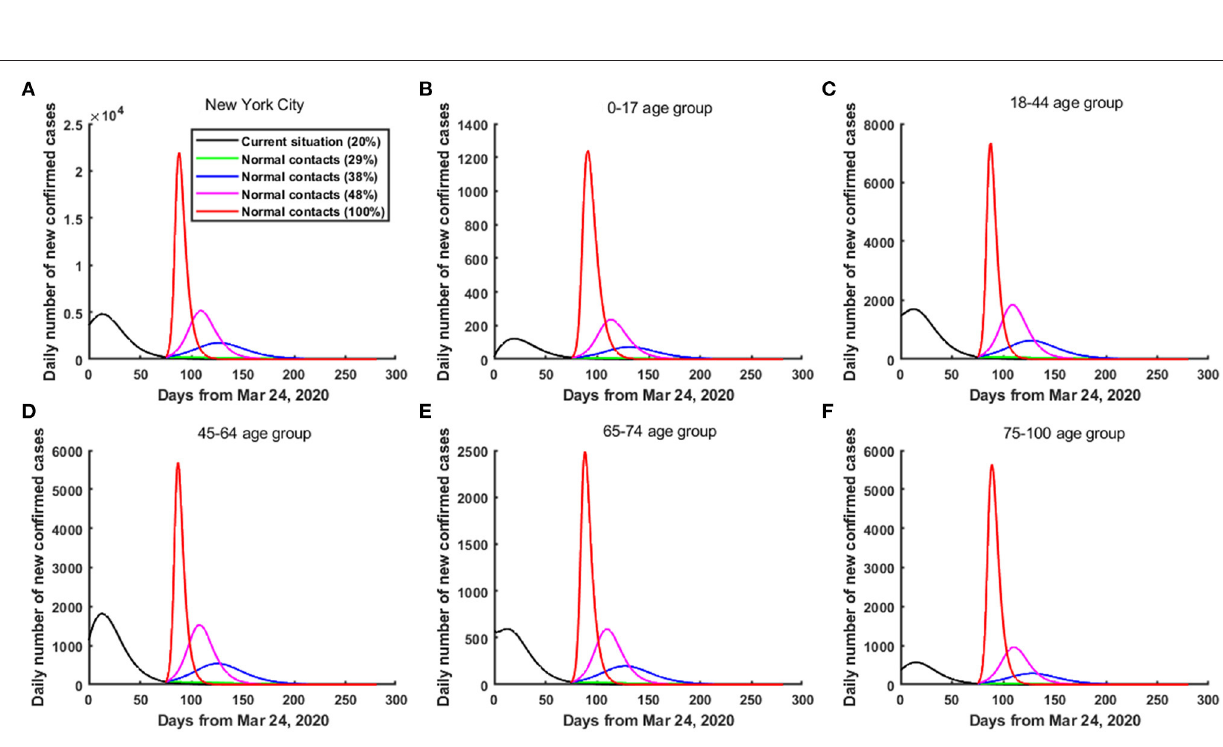
Frontiers in Medicine |